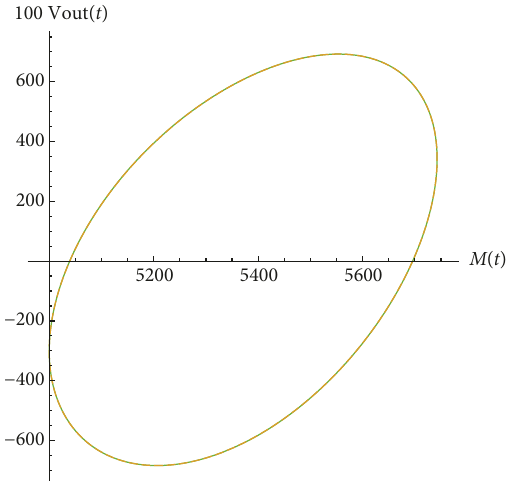
Figure 27: 𝑉 𝑜𝑢𝑡 (𝑡) versus 𝑀(𝑡) of Type A Wien oscillator: fractional memristor with 𝛼 = 1 (green line) and HP memristor (orange dashed).